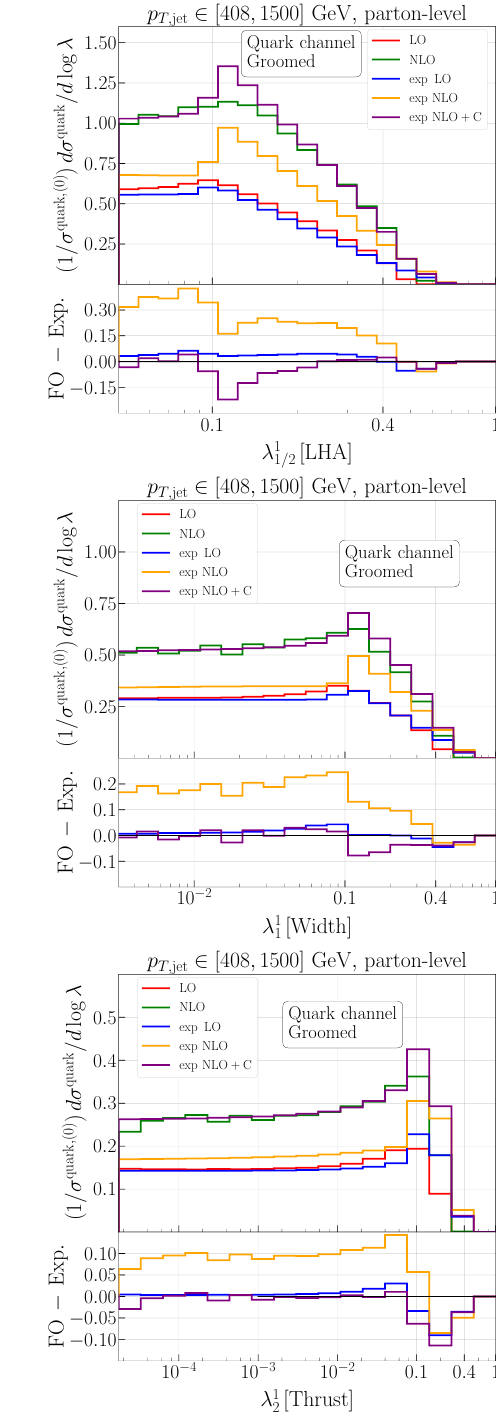
, for α ∈ { 1 / 2 , 1 , 2 } , compared α